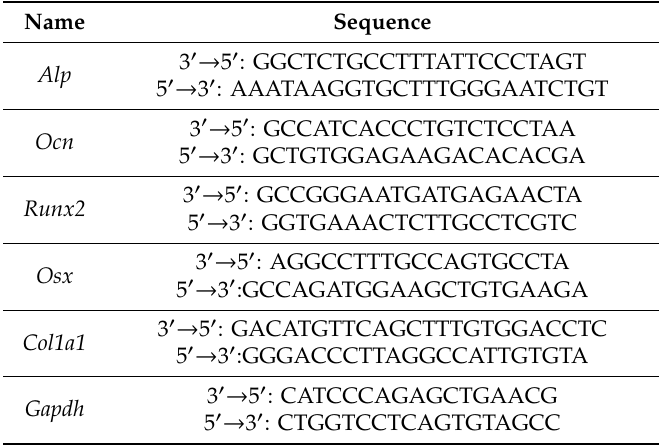
Table 1. Primers used for